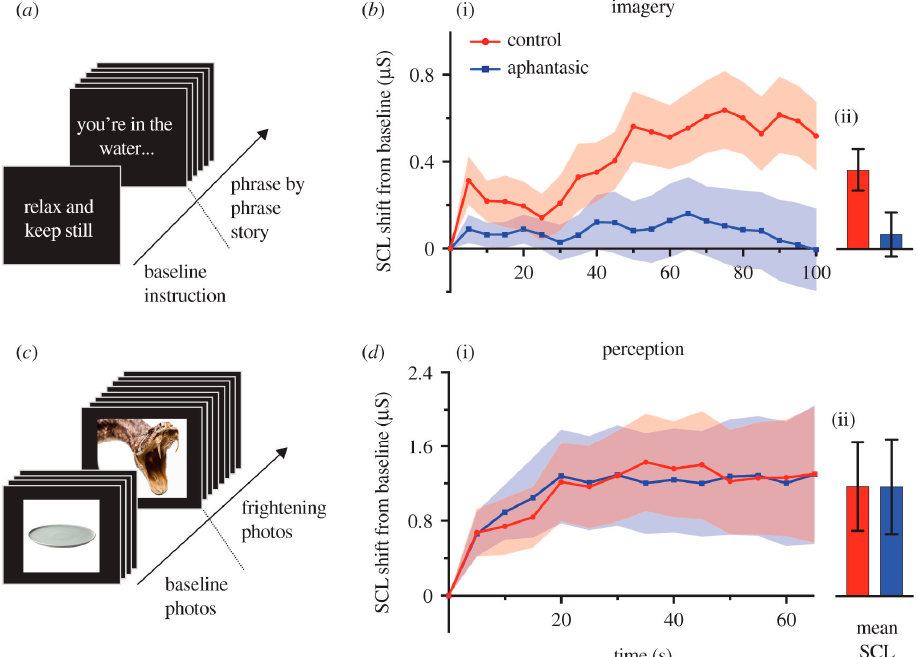
Figure 7. Skin conductance data for imagery and perception experiments with aphantasics and controls. ( a ) Imagery experiment. Fifty seconds of baseline SCL was recorded prior to each scenario trial while participants viewed an on-screen instruction. Next, each scenario trial was presented to participants as a succession of 50 on-screen phrases, each displayed for 2 s. ( b ) (i) Aggregated progressions of baseline-corrected SCL across the duration of scenarios (sampled as average across 5 s time bins). (ii) Mean and SEM across time bins. ( c ) Perception experiment. Baseline SCL was recorded while participants viewed neutral photos, before being presented with a succession of frightening photos. Photos appeared on screen for 5 s each and immediately followed one another. ( d ) (i) Aggregated progressions of baseline-corrected SCL across the duration of the frightening photos sequence (sampled as average across 5 s time bins). (ii) Mean and SEM across time bins. Reprinted with permission from ref. [88]. 2021. M. Wicken et al.